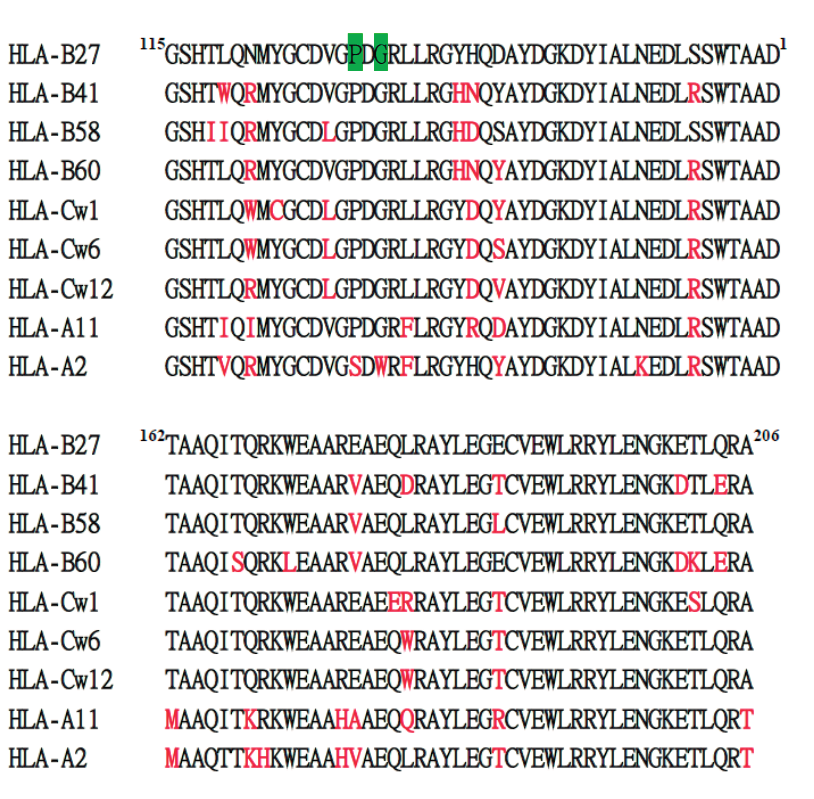
Figure 3. Amino acid sequence alignment of HLA-B27 HC α 2 domain with that of the indicated HLA-B, -C, and -A molecules. BH2 binds to HLA-B27, -B41, -B58, -B60, -Cw1, -Cw6, -Cw12 and -A11, but not to HLA-A2 in HLA-typing assay. The non-consensus residues compared with HLA-B27 are marked with red. Double replacements of Pro-129 and Gly-131 of HLA-B27 HC with Ser and Trp, respectively, are marked as